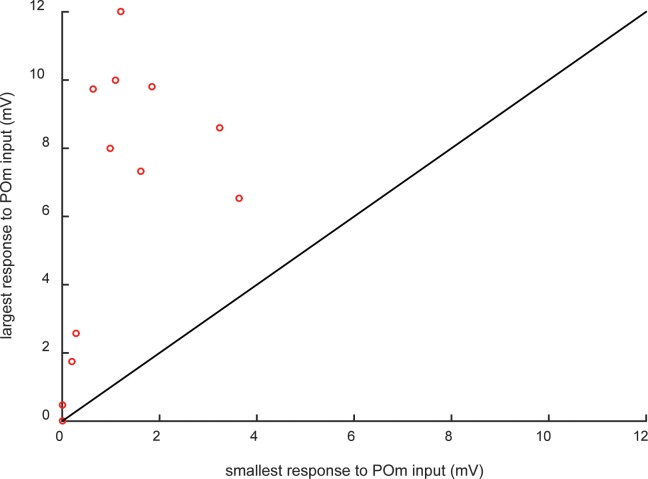
Individual animals exhibited wide ranges of POm input strengths.Multiple L2/3 cortical neurons per animal were recorded in 15 of the POm-infected rats. Each circle indicates the smallest and largest PSPs observed in a rat. Cells with the strongest POm inputs (>6 mV) are observed in the same rats in which cells receiving relatively weak POm input, as much as 10 times smaller. If cells with strong POm inputs were regularly found in the same animals (due to injection variability), individual rats would have fallen close to the unity line.